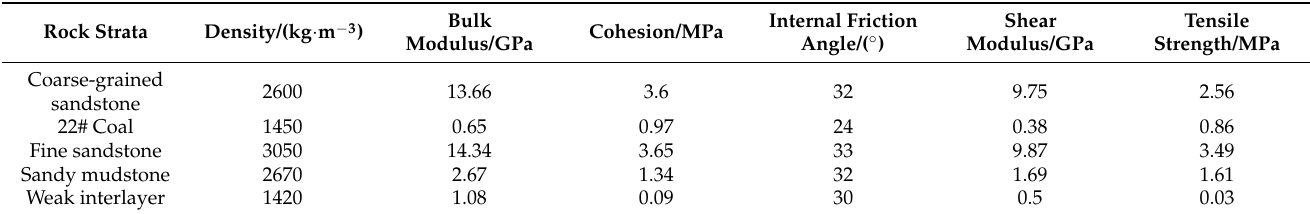
Table 2. Physical and mechanical parameters of roadway rock strata and